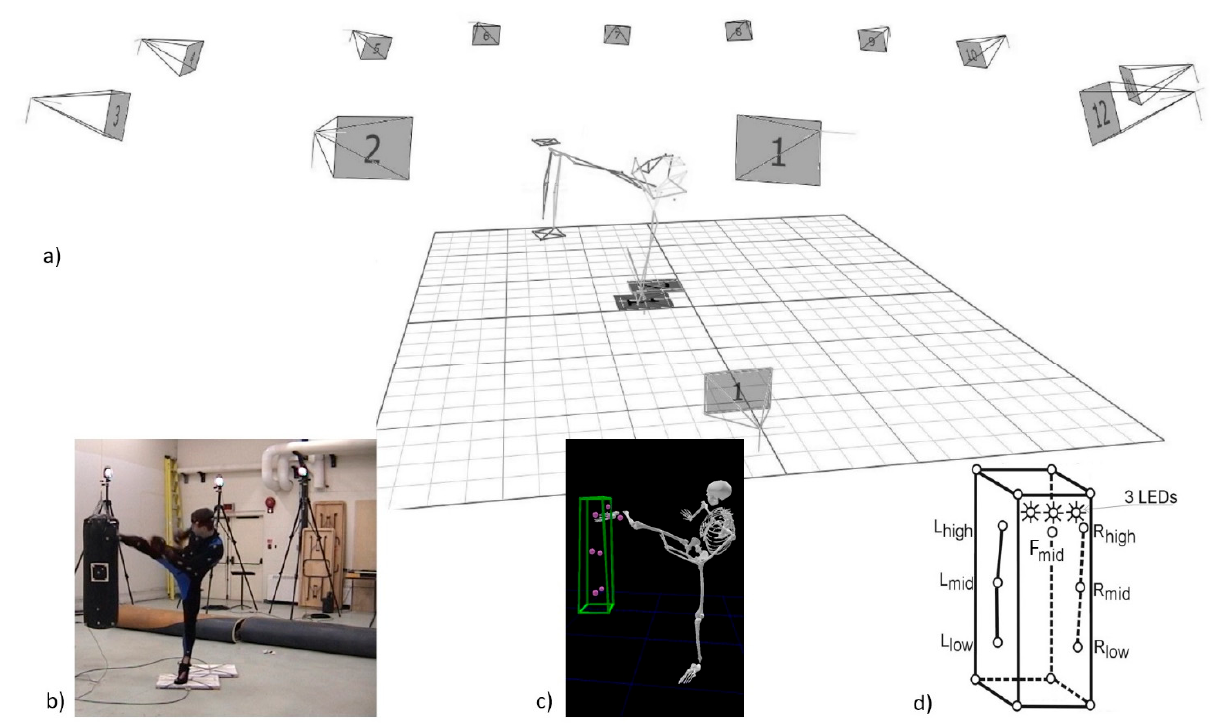
Figure 1. The synchronized data collection: ( a ) the set-up of the data collection; ( b ) a sample frame; ( c ) the biomechanical modeling based on 3D motion capture data; ( d ) the set-up of the target markers and LEDs on the bag.